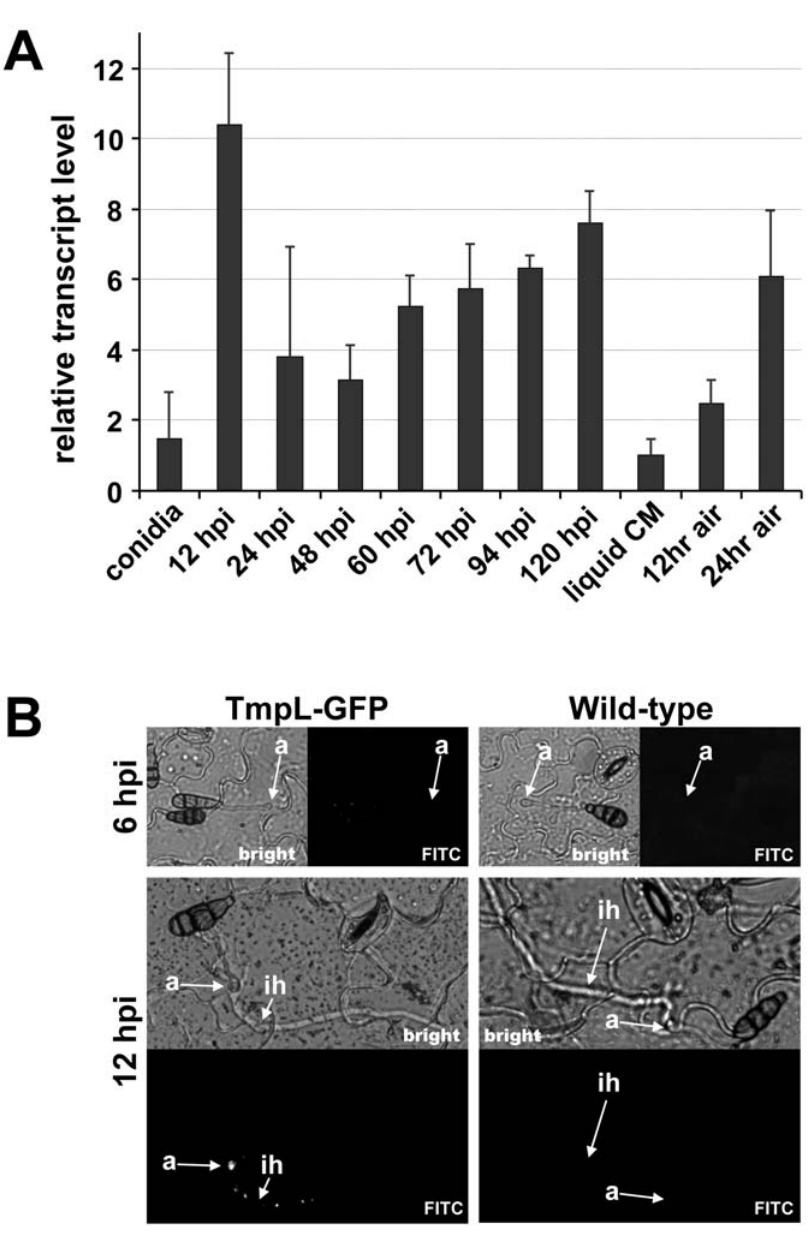
Figure 4. Phase specific expression of A.brassicicolatmpL . ( A ) The phase specific expression of tmpL was quantified by quantitative real-time (QRT)-PCR after synthesis of cDNA of each developmental RNA including infectious growth, vegetative growth, and conidiation. Relative abundance of tmpL transcripts during infectious growth (from ungerminated conidia to in planta fungal cells 120 hpi) and conidial development (from 12 hr air- exposed mycelia to 24 hr air-exposed mycelia) was normalized by comparing with vegetative growth in liquid CM (set to transcript level=1). ( B ) Epifluorescence microscopy of in planta GFP expression for the TmpL-GFP strain. The germ tubes and appressoria did not exhibit any GFP signal on the plant surface at 6 hpi. However, a GFP signal was detectable at 12 hpi in a punctate pattern in the appressoria and infection hyphae growing within the plant tissue, consistent with the QRT-PCR results. The wild-type strain was used as a control. Abbreviations: a, appressorium; ih, infection hypha.